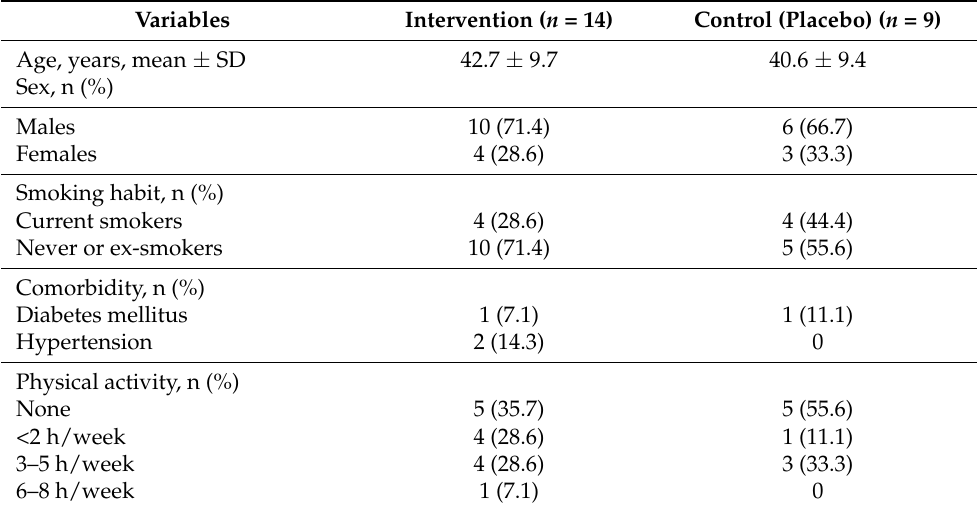
Table 1. Baseline characteristics of the study population.